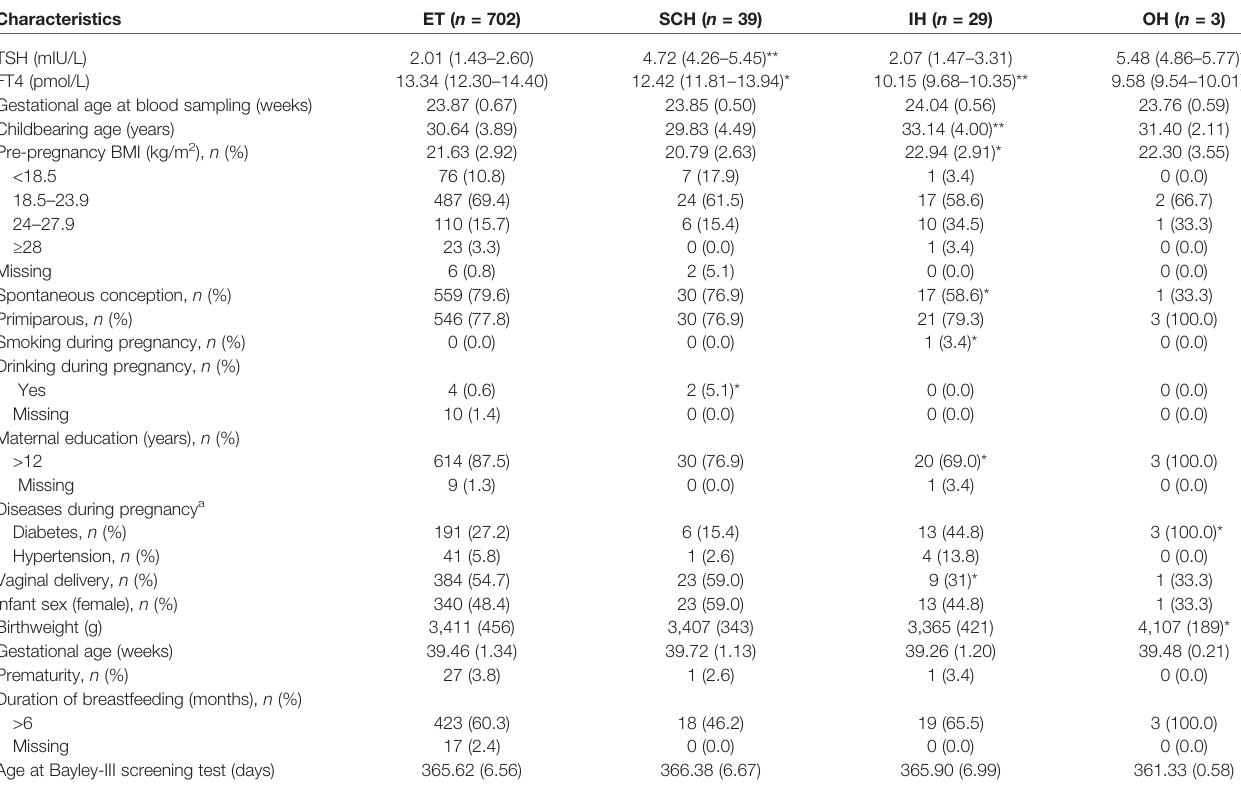
TABLE 1 | Characteristics of mother – infant pairs.